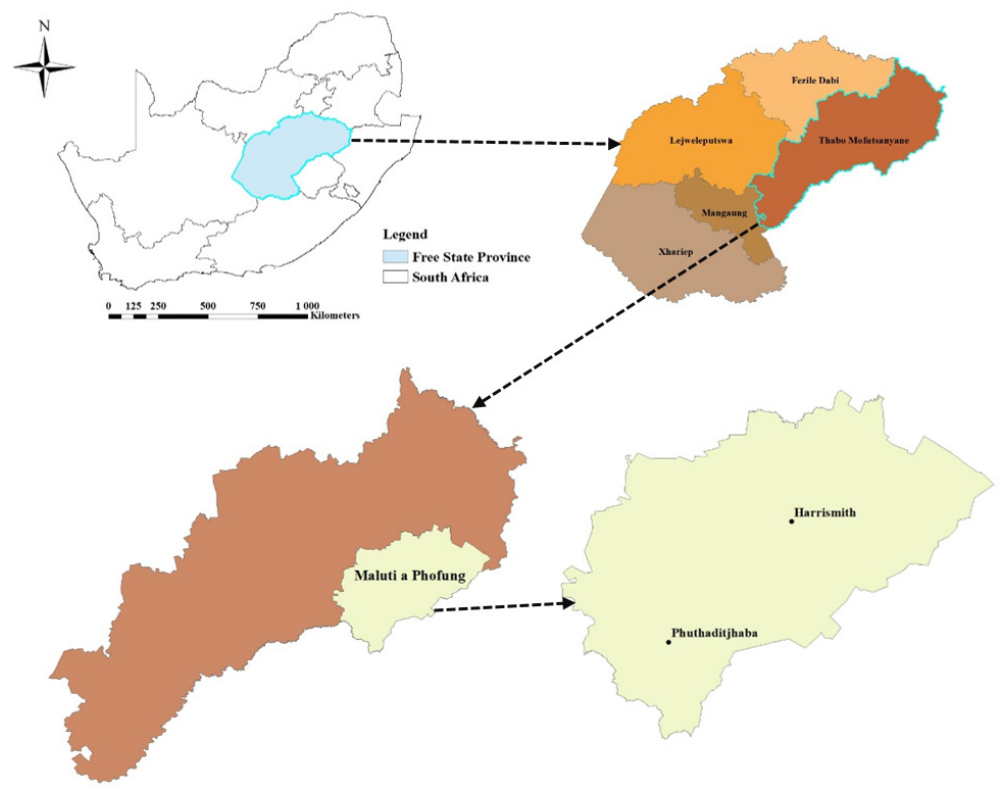
Figure 1. Location of the study area